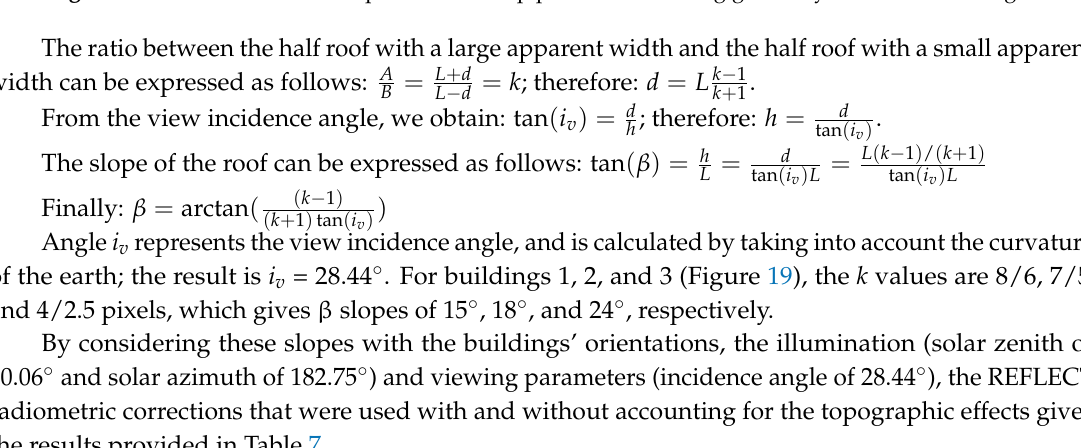
Figure 21. Calculation of the slope of the rooftop parts from viewing geometry of the Ikonos image.